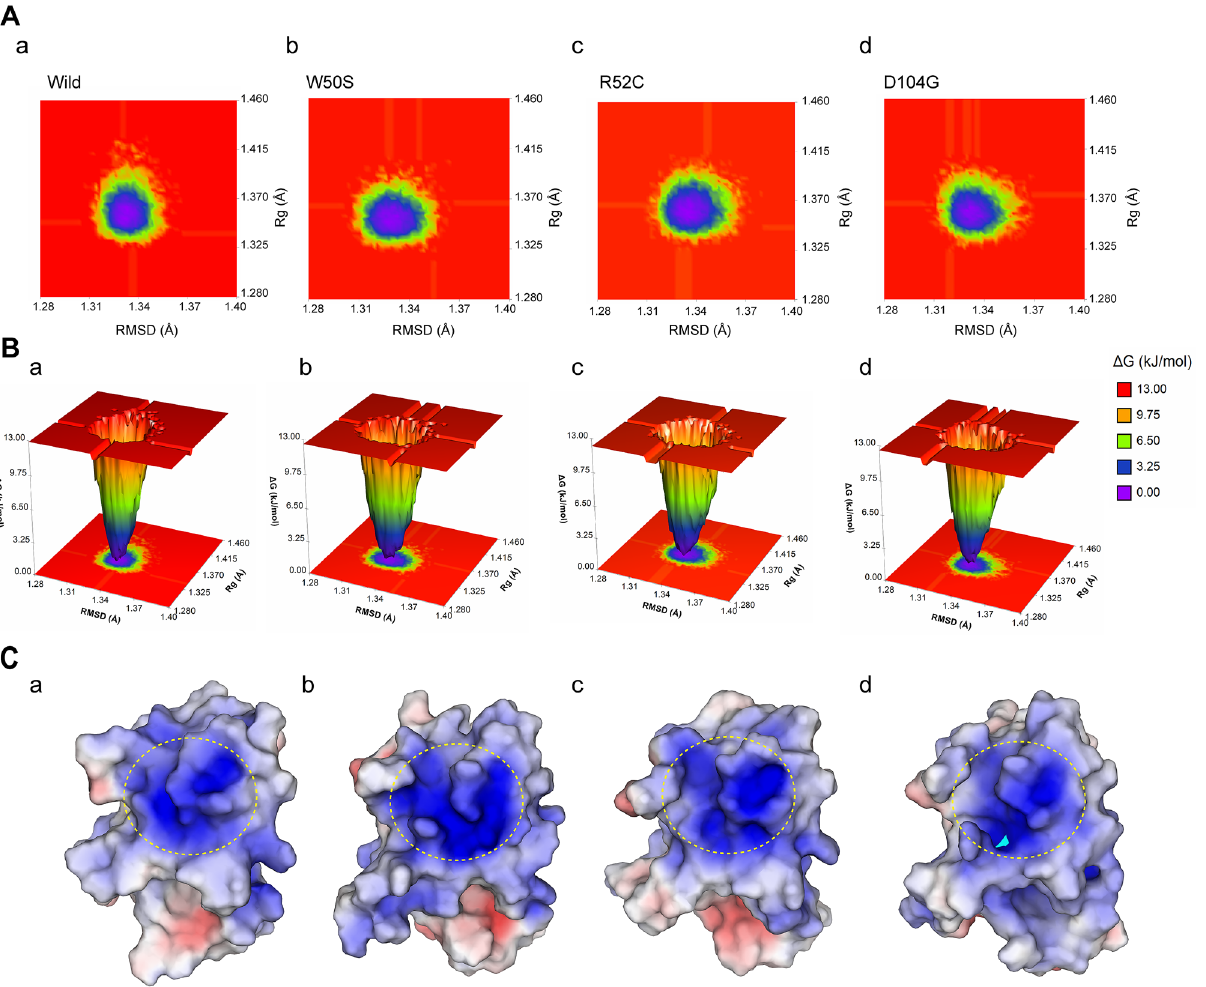
Figure 7. Effect of variants on the positive electrostatic potential near CDRs. ( A ) Free energy contour maps showing conformational distributions according to depth of energy minima for the wild-type ( a ), W50S ( b ), R52C ( c ), and D104G ( d ). Energy states as demonstrated by a color-coded map, where purple indicates a protein conformer with a lower energy minimum, and red a higher energy minimum then the wild-type. ( B ) Three- dimensional representation of the free energy landscapes (FEL) or the wild-type ( a ), W50S ( b ), R52C ( c ), and D104G ( d ). ( C ) Surface map of positive electrostatic potentials near the PLIR for the wild-type ( a ), W50S ( b ), R52C ( c ), and D104G ( d ) variants. The map was constructed using the lowest energy conformers retrieved from FEL, at corresponding timestamps of 292.5 (wild-type), 639.1 (W50S), 827.6 (R52C), and 868.1 ns (D104G). Darker blue regions indicate electropositive areas (> 6 kT/e), and red regions electronegative areas (< -6 kT/e). The yellow dotted line indicates the